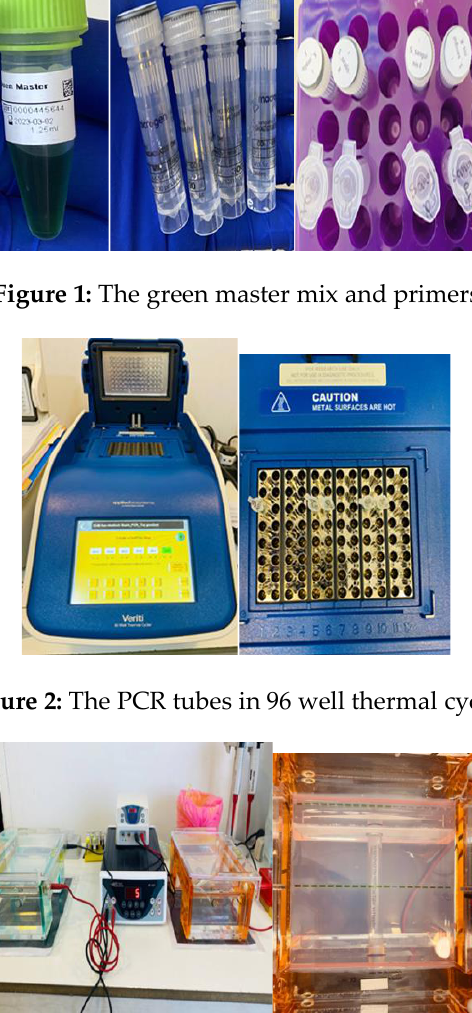
Figure 3: Gel Electrophoresis